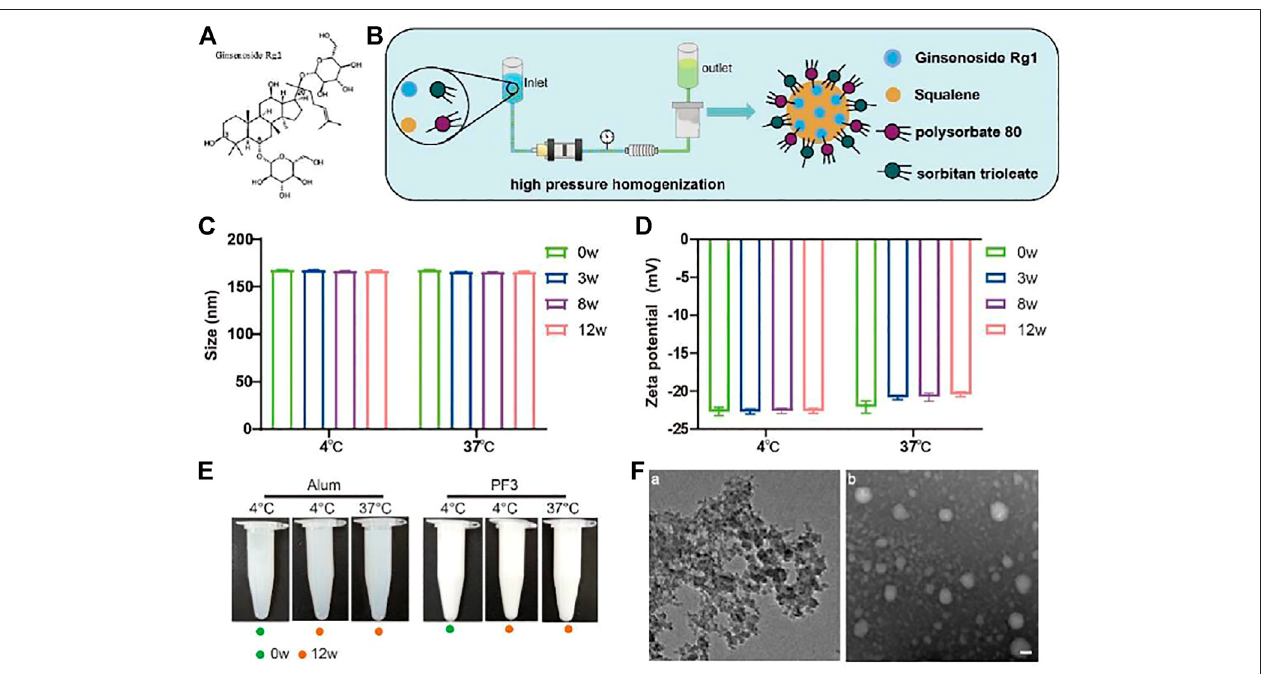
FIGURE1| PreparationandcharacterizationofPF3. (A). ChemicalstructureofginsenosideRg1. (B). SchematicillustrationofPF3preparationprocess. (C,D). Size andZetapotentialofPF3after0,3,8and12weeksofstorgeattheindicatedtemperature. (E). AppearanceofaluminiumhydroxideandPF3after0or12weeksofstorge at the indicated temperature. (F). TEM images of aluminium hydroxide (a) and PF3 (b) . Scale bar represents 100